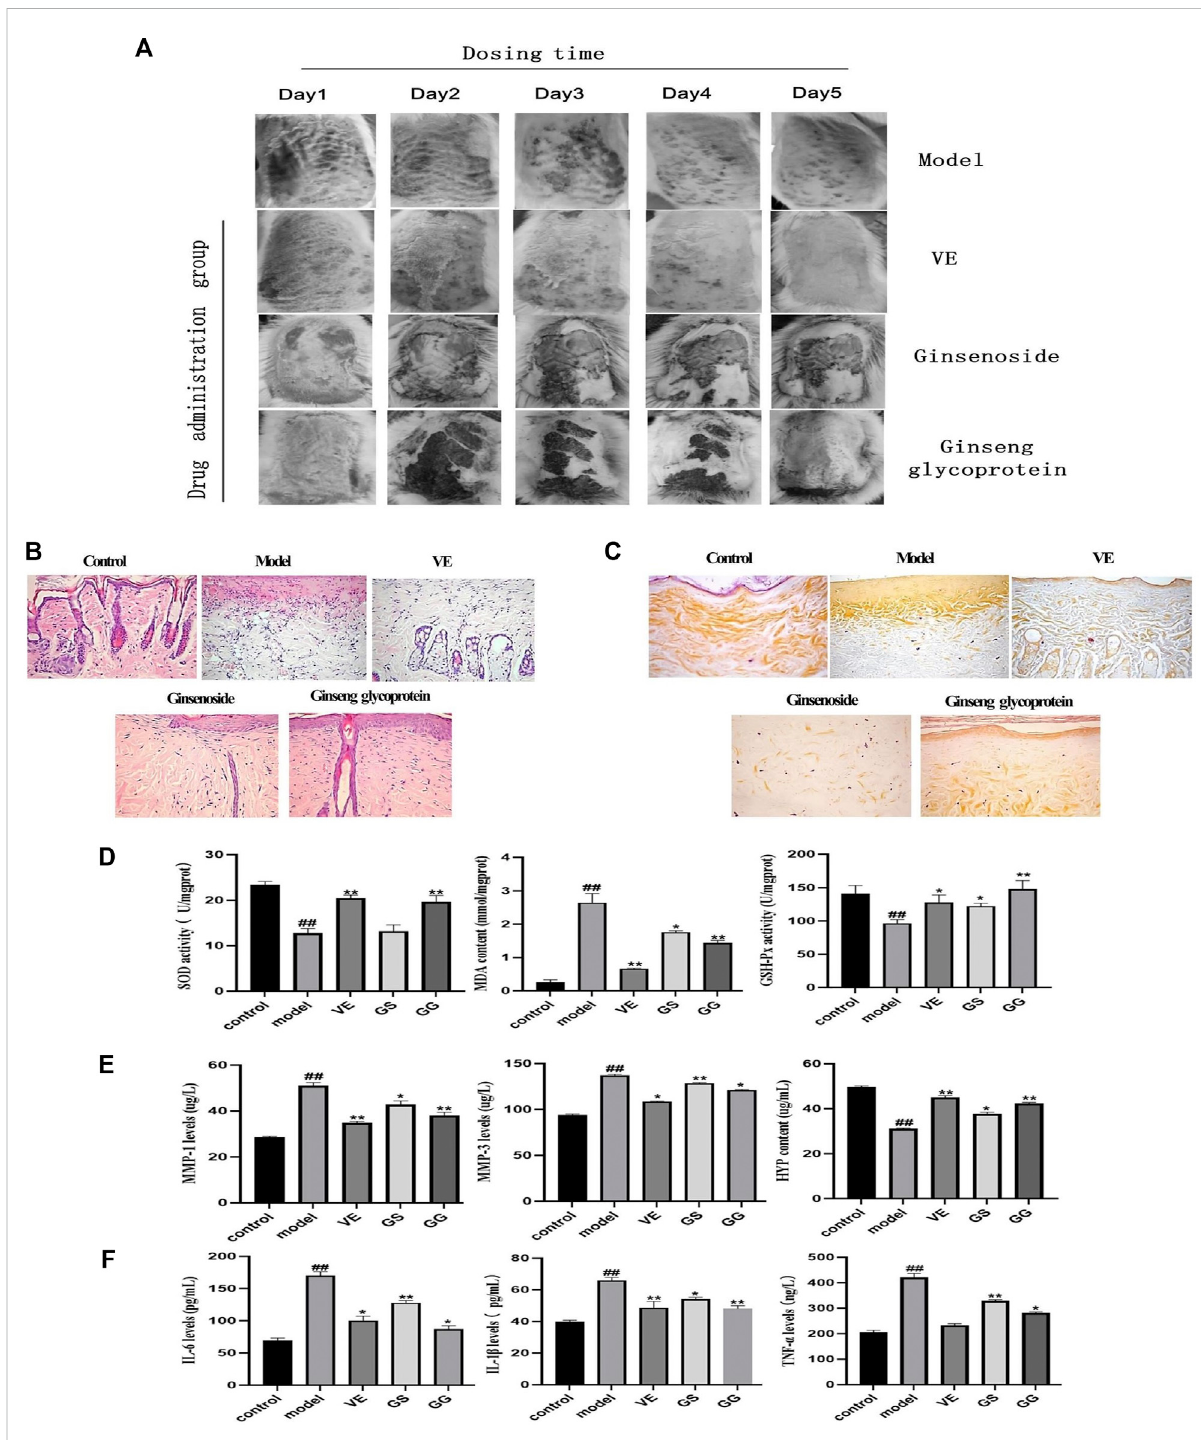
FIGURE 5 Ginsenoside and ginseng glycoprotein can improve skin damage caused by diabetes combined with UV irradiation in rats. (A) Changes in the appearanceofdiabeticratsafter5 daysofcontinuousdosing; (B) HistologyofskinbyH&Estainingoftheskin;tissuesection(×200); (C) Histologyof skinbyaldehydefuchsinestainsoftheskintissuesection(×200); (D) ExpressionofMDA,SODandGSH-Pxintheskinhomogenatesofdiabeticratsin differentgroups; (E) Theexpressionofmatrixmetalloproteinase1(MMP-1),matrixmetalloproteinase3(MMP-3)andhydroxyproline(HYP)inrat skin tissues was detected by enzyme-linked immunosorbent assay (ELISA); (F) The expression of tumor necrosis factor- α (TNF- α ), interleukin-1 β (IL- 1 β )andinterleukin-6(IL-6)inratserumwasmeasuredbyenzyme-linkedimmunosorbentassay(ELISA).Ginsenoside(GS),Ginsengglycoprotein(GG) # p < 0.05 ## p < 0.01 ### p < 0.001 versus control group; * p < 0.05 ** p < 0.01 *** p < 0.001 versus model group. Data are expressed as mean values ± SD ( n =